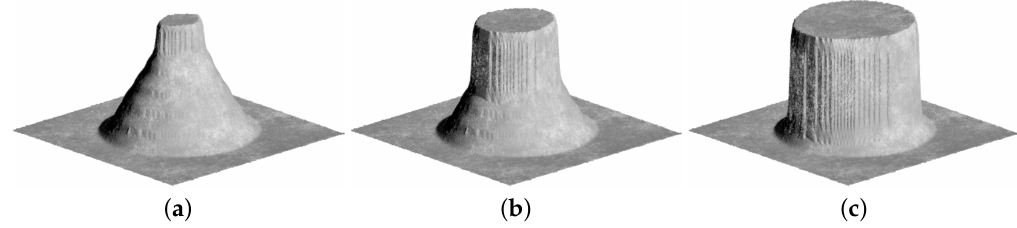
Figure 17. Comparison of the impact of the combination of materials’ hardness on the model geometry shown in Figure 16c. ( a ) 2 top materials combined. ( b ) 4 top materials combined. ( c ) 6 top materials combined.